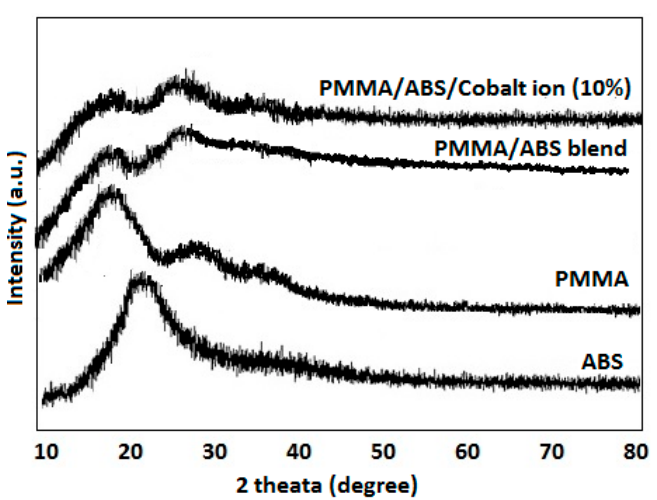
Figure 2. XRD pattern of PMMA/ABS/CoCl 2 composite.